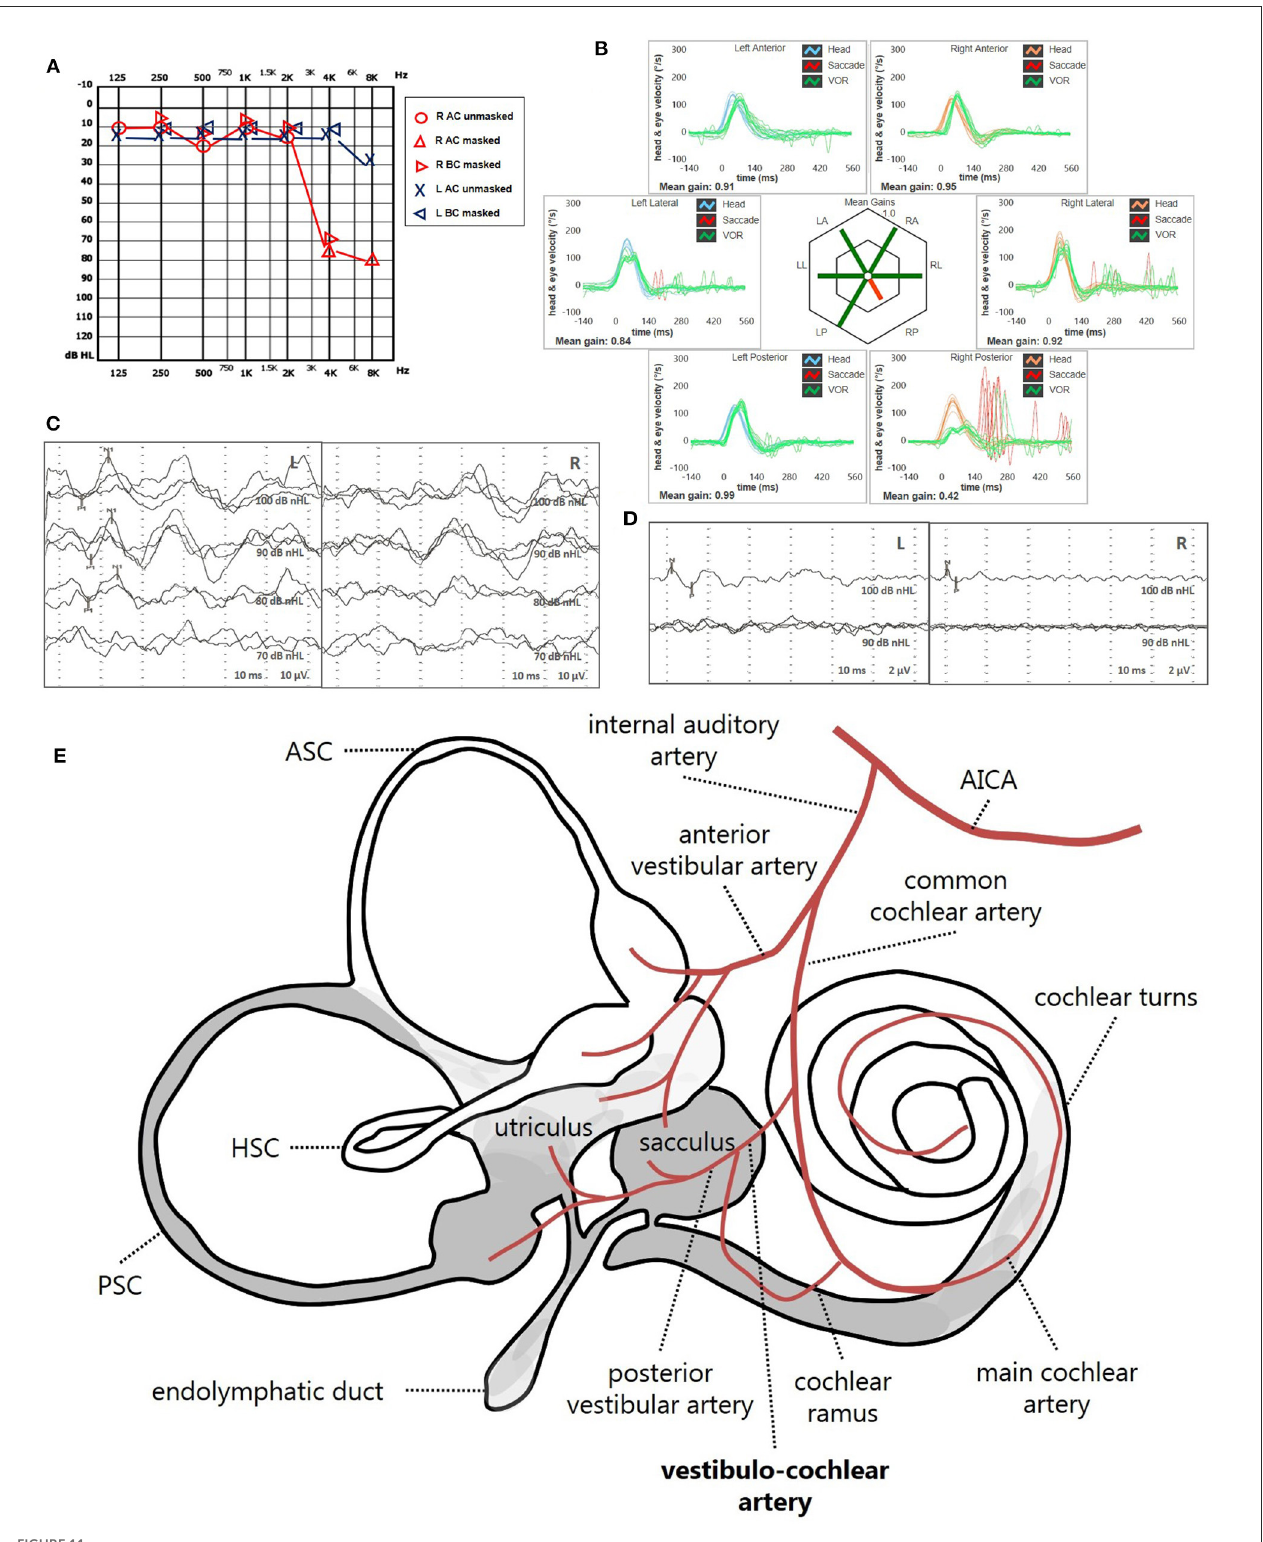
FIGURE11 Presenting scenario of patients #42 with an instrumental lesion pattern consistent with an ischemic damage in the territory mainly supplied by the right VCA (see also the Supplementary Video 1). (A) Pure-tone audiometry exhibiting high-frequency sensorineural HL on the right side. (B) vHIT showing a selective VOR-gain impairment for the right PSC (0.42) with overt saccades. (C) cVEMPs revealing absent potentials on the right side and normal responses on the left side (AR = 100%). (D) oVEMPs with potentials on both sides with an amplitude asymmetry within normality range (L > R, AR = 29%). (E) Schematic representation of the vascular supply of the inner ear, highlighting the assumed ischemic pathomechanism [modified from Schuknecht (63)]. Labyrinthine receptors mainly supplied by the VCA are represented in gray. AC, air-conduction; AICA, anterior-inferior cerebellar artery; ASC, anterior semicircular canal; BC, bone-conduction; cVEMPs, cervical vestibular-evoked myogenic potentials; HSC, horizontal semicircular canal; L, left; LA, left anterior; LL, left lateral; LP, left posterior; oVEMPs, ocular vestibular-evoked myogenic potentials; PSC, posterior semicircular canal; R, right; RA, right anterior; RL, right lateral; RP, right posterior; VCA, vestibulo-cochlear artery; vHIT, video-head impulse test; VOR, vestibulo-ocular